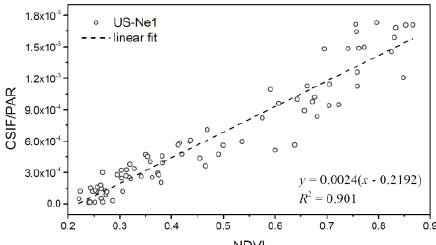
Figure 2. An example (US-Ne1 site) of using apparent SIFy (CSIF divided by PAR) to calculate site-specific bias of NDVI.